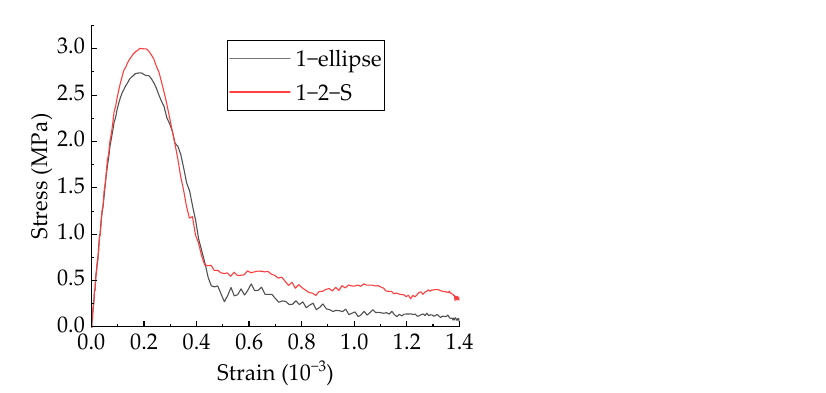
Figure 27. Stress − strain curves of elliptical pore specimen 1-ellipse and specimen 1-2-S. Table 8. The mechanical properties of Specimen 1-ellipse and Specimen 1-2-S.